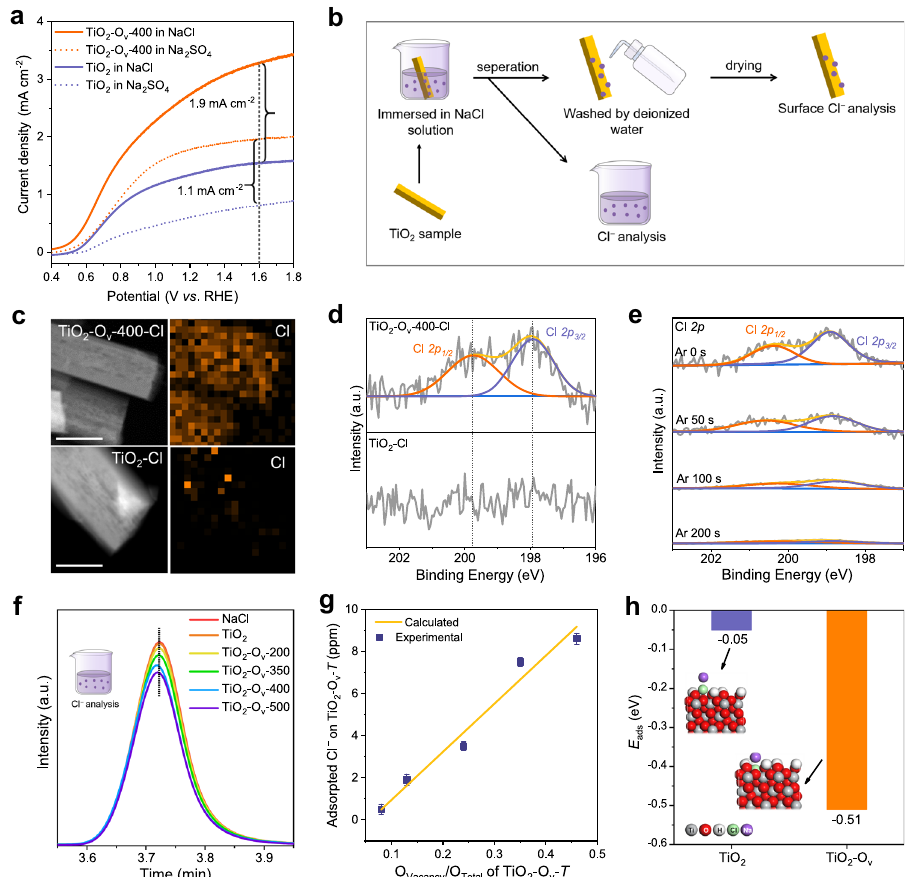
Fig. 5 Mechanistic investigation of enriched Cl − at oxygen-vacancy sites. a LSV curves at scan rate of 10 mV s − 1 in 0.5 M Na 2 SO 4 or NaCl electrolyte under AM 1.5G (100 mW cm − 2 ) illumination. b Schematic diagram of the pretreatment process of TiO 2 -O v -400 and TiO 2 samples for further measurements (denoted as TiO 2 -O v -400-Cl and TiO 2 -Cl). c STEM combined EDS mapping images of TiO 2 -O v -400-Cl and TiO 2 -Cl. Scale bars: 100 nm. d Cl 2p XPS spectra of TiO 2 -O v -400-Cl and TiO 2 -Cl. e ARXPS spectra of Cl on TiO 2 -O v -400-Cl after Ar + sputtering. f IC spectrogram of NaCl solution after adsorbed by different TiO 2 -O v - T samples. g Cl − adsorption behavior of TiO 2 -O v -400 with different concentration of oxygen vacancy. h Adsorption energy of Cl − over TiO 2 and TiO 2 -O v . Inset: optimized geometries for TiO 2 and TiO 2 -O v adsorbed with Cl − , the color of each element is also labeled. a.u.: arbitrary (EDS) mapping results in Fig. 5c and Supplementary Fig. 19